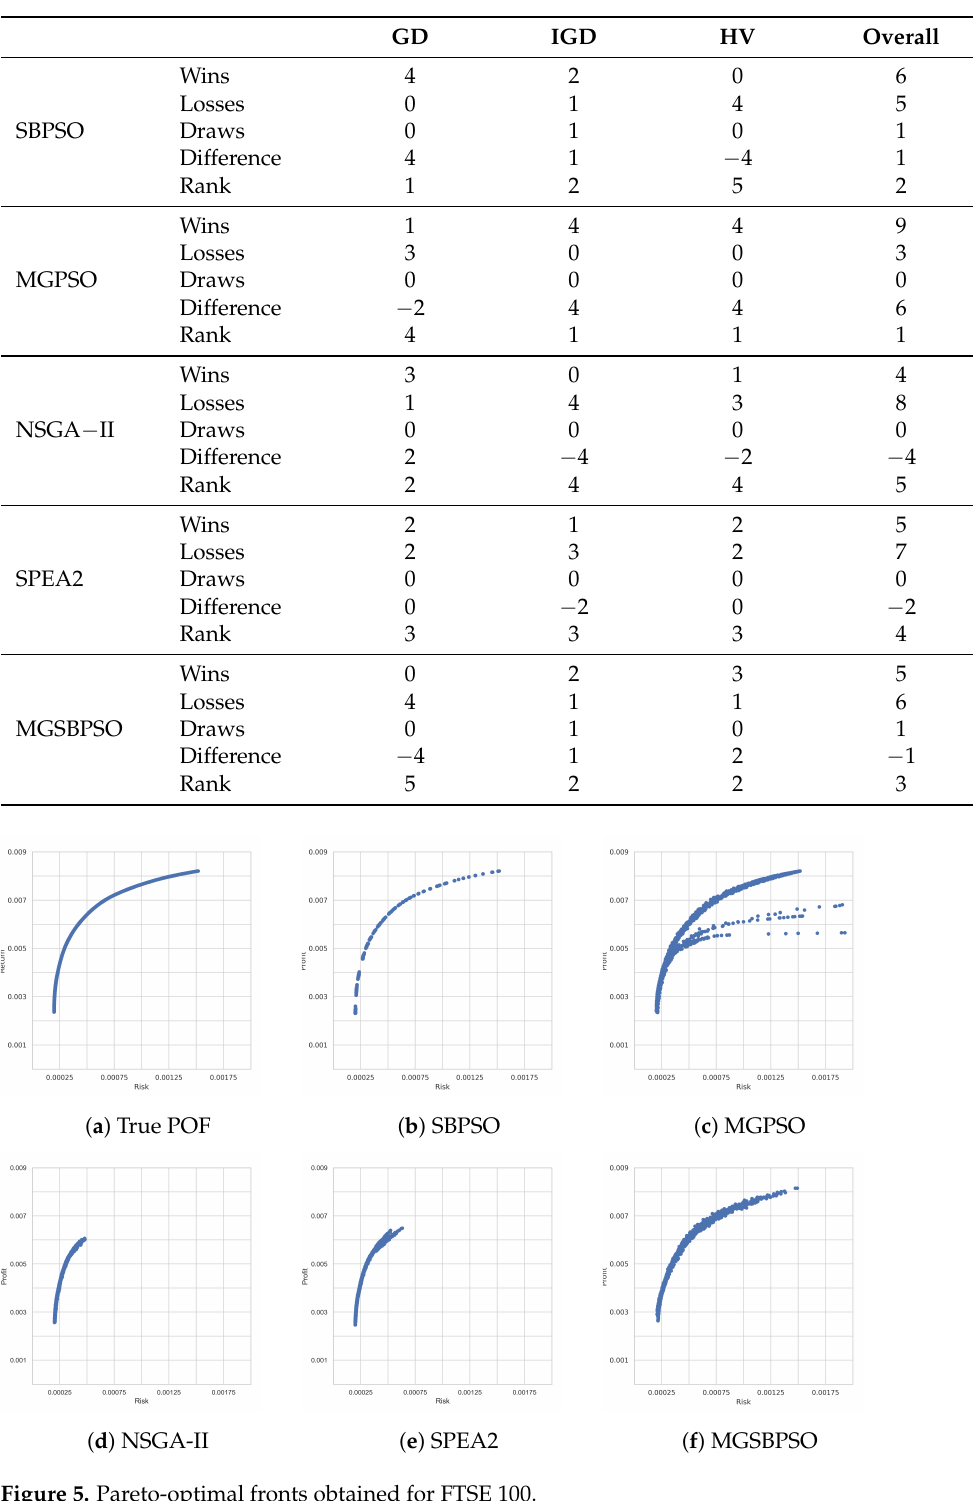
Table 10. FTSE 100 rankings for each performance measure.